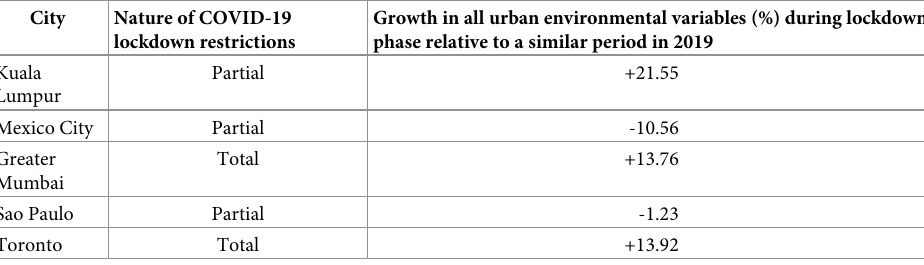
Table 3. Impact of COVID-19 lockdown restriction on Alpha cities relative to similar period in